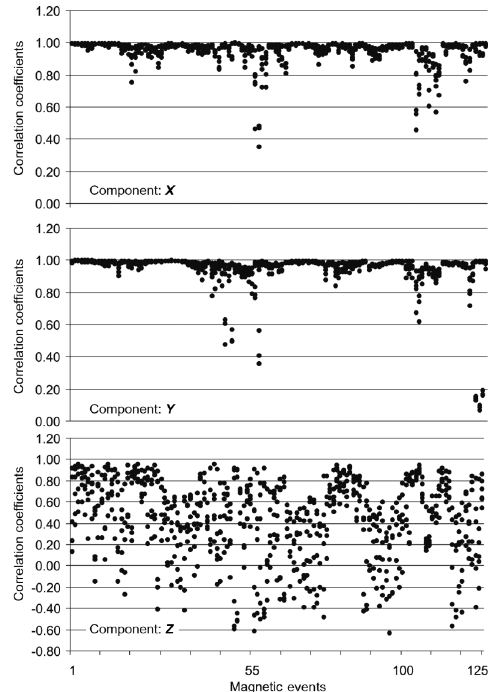
Fig. 2. Cross-correlation coefficients calculated for stations SSL, GRN, RDK,